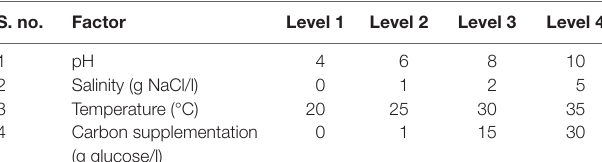
TaBle 1 | selected factors and assigned levels. s.